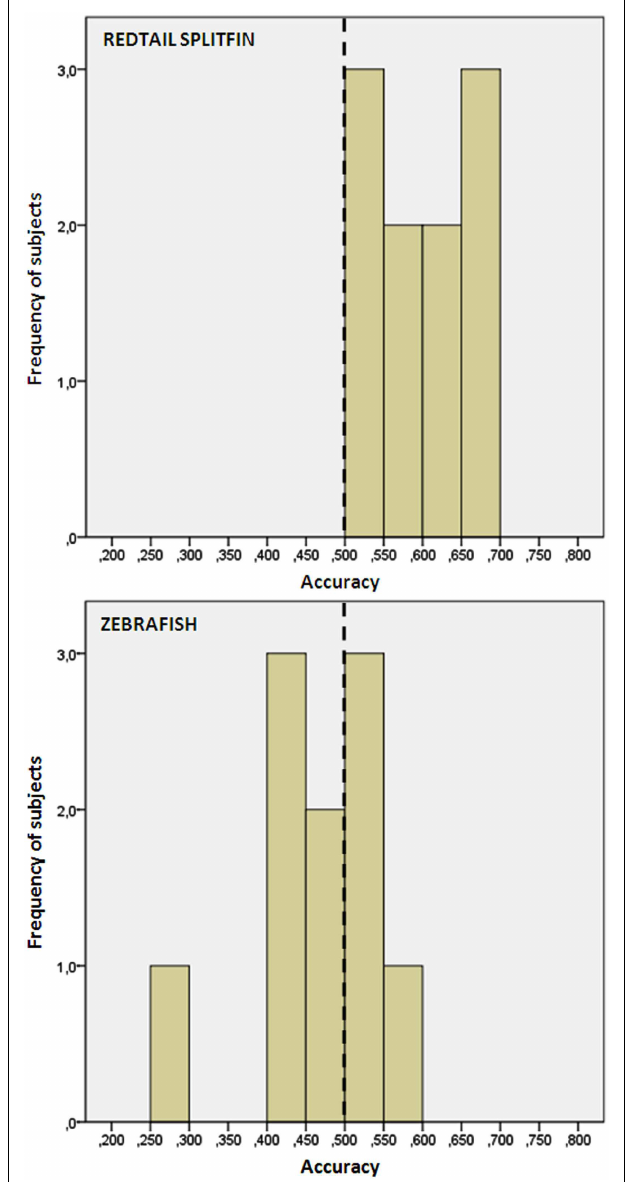
FIGURE 4 | Frequency distribution of the preference score of zebrafish and redtail splitfin in the shape discrimination task of experiment 2. Redtail splitfin significantly preferred the reinforced stimulus, while the performance of zebrafish is indistinguishable from random